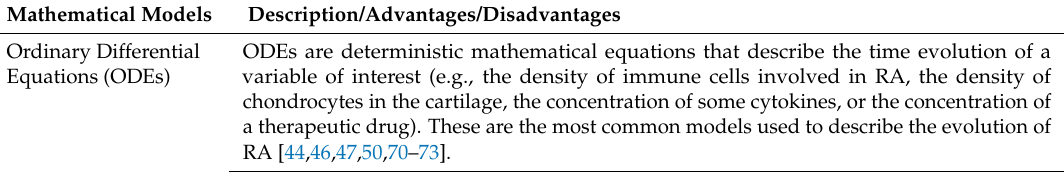
Table 2. Summary of the main types of mathematical models used to describe the evolution and possible treatment approaches for